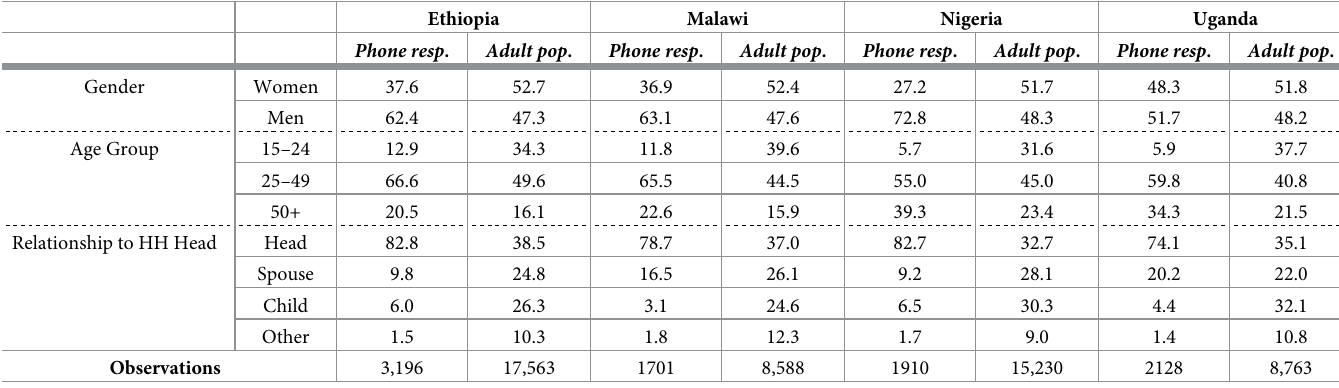
Table 2. Unweighted descriptive statistics for HFPS respondents and adult population in F2F survey. Ethiopia Malawi Nigeria Uganda Phone resp . Adult pop . Phone resp . Adult pop . Phone resp . Adult pop . Phone resp . Adult pop .